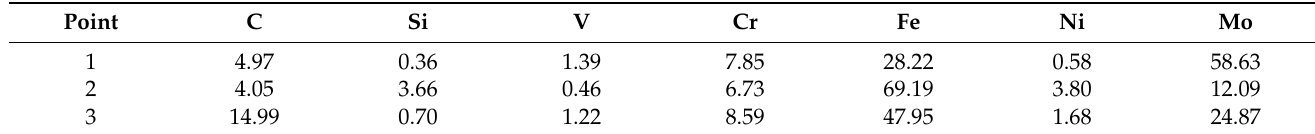
Figure 9. The microstructure of different coatings: ( a ) S1; ( b ) S2; ( c ) S3; ( d ) S4. Table 7. EDS results of different points in Figure 9d (wt.%).